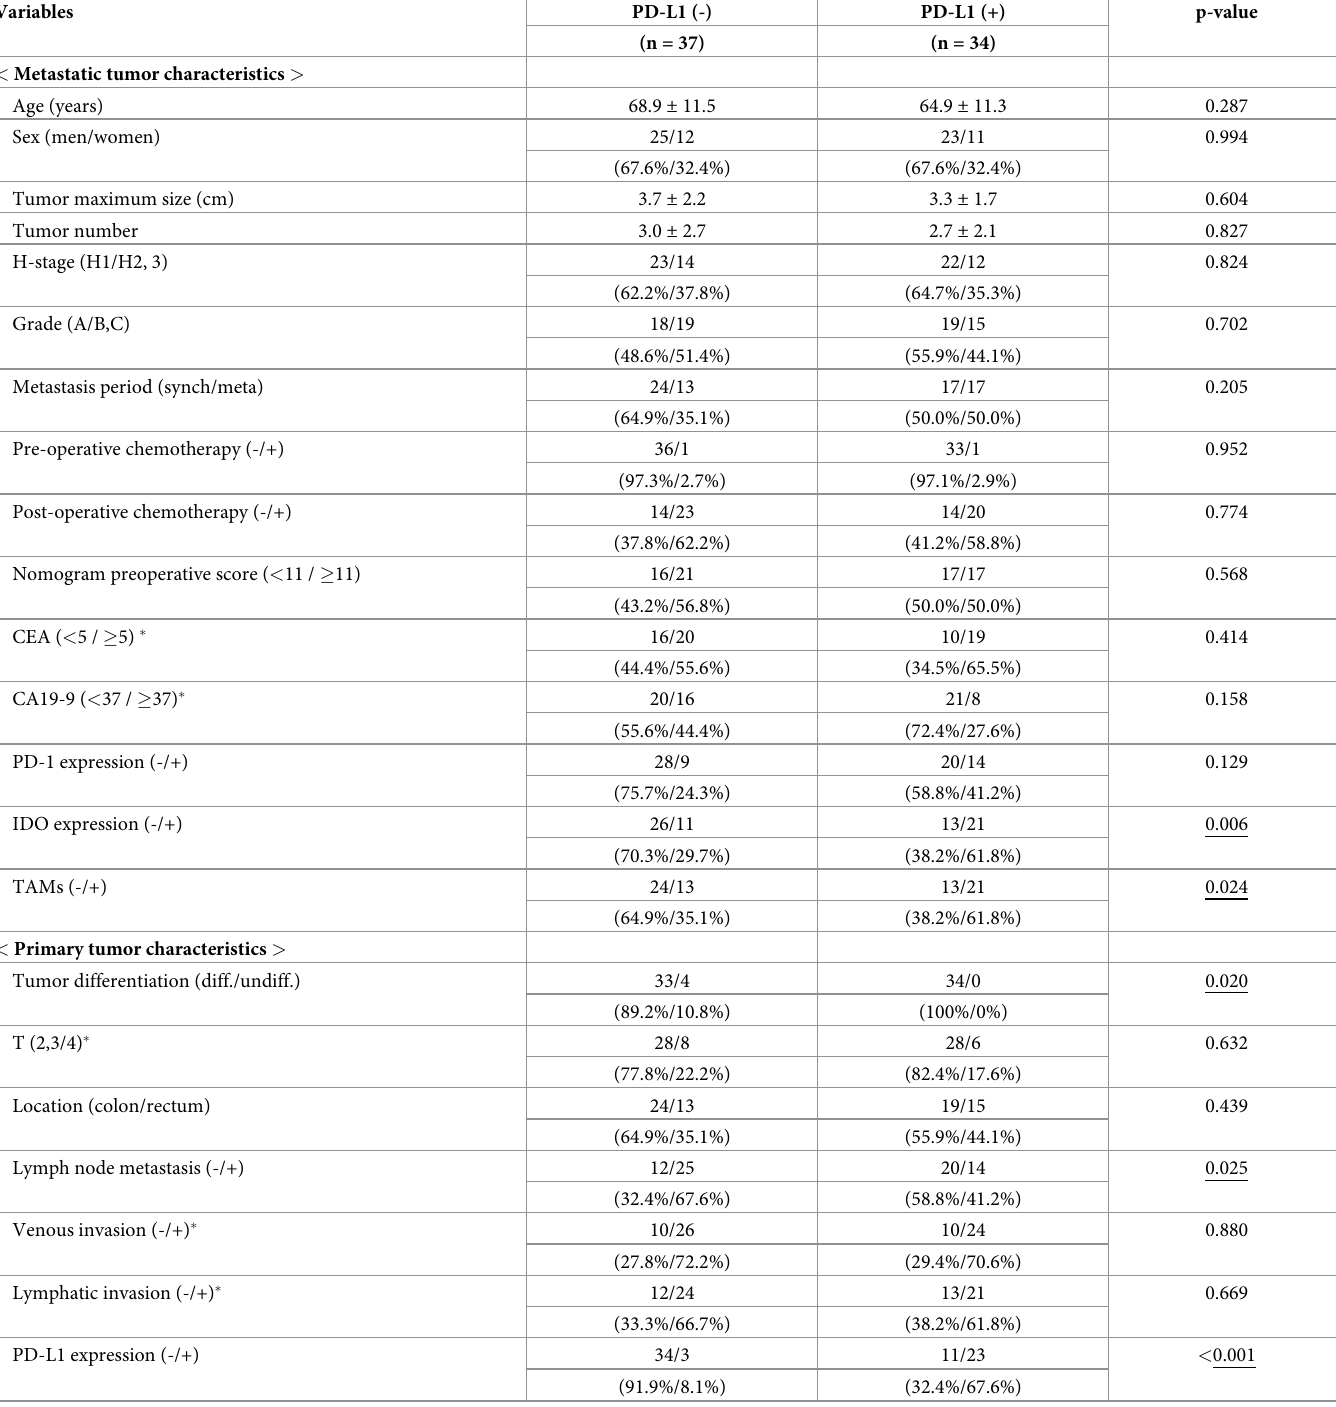
Table 2. Patients’ clinicopathological characteristics according to PD-L1